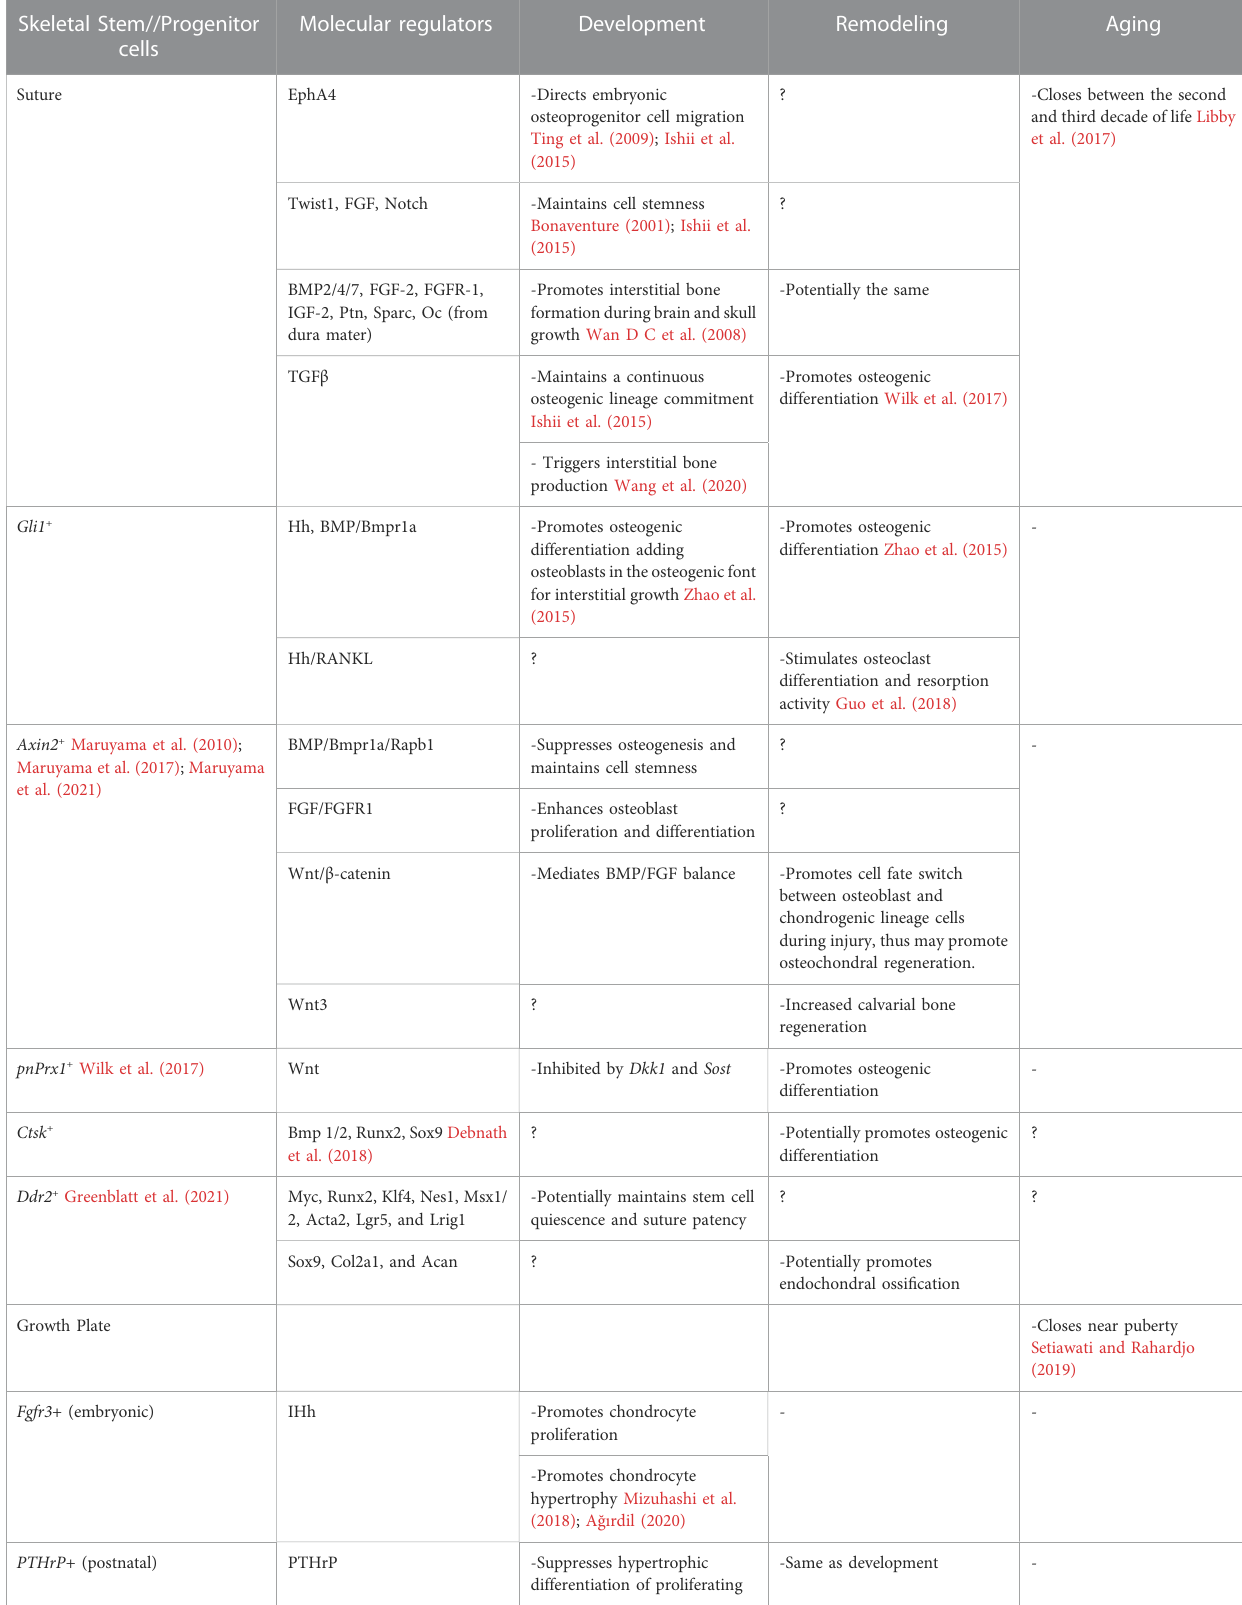
TABLE 1 Summary of the regulations of distinct skeletal stem//progenitor cells (SSPCs) in different skeletal compartments during development, remodeling and